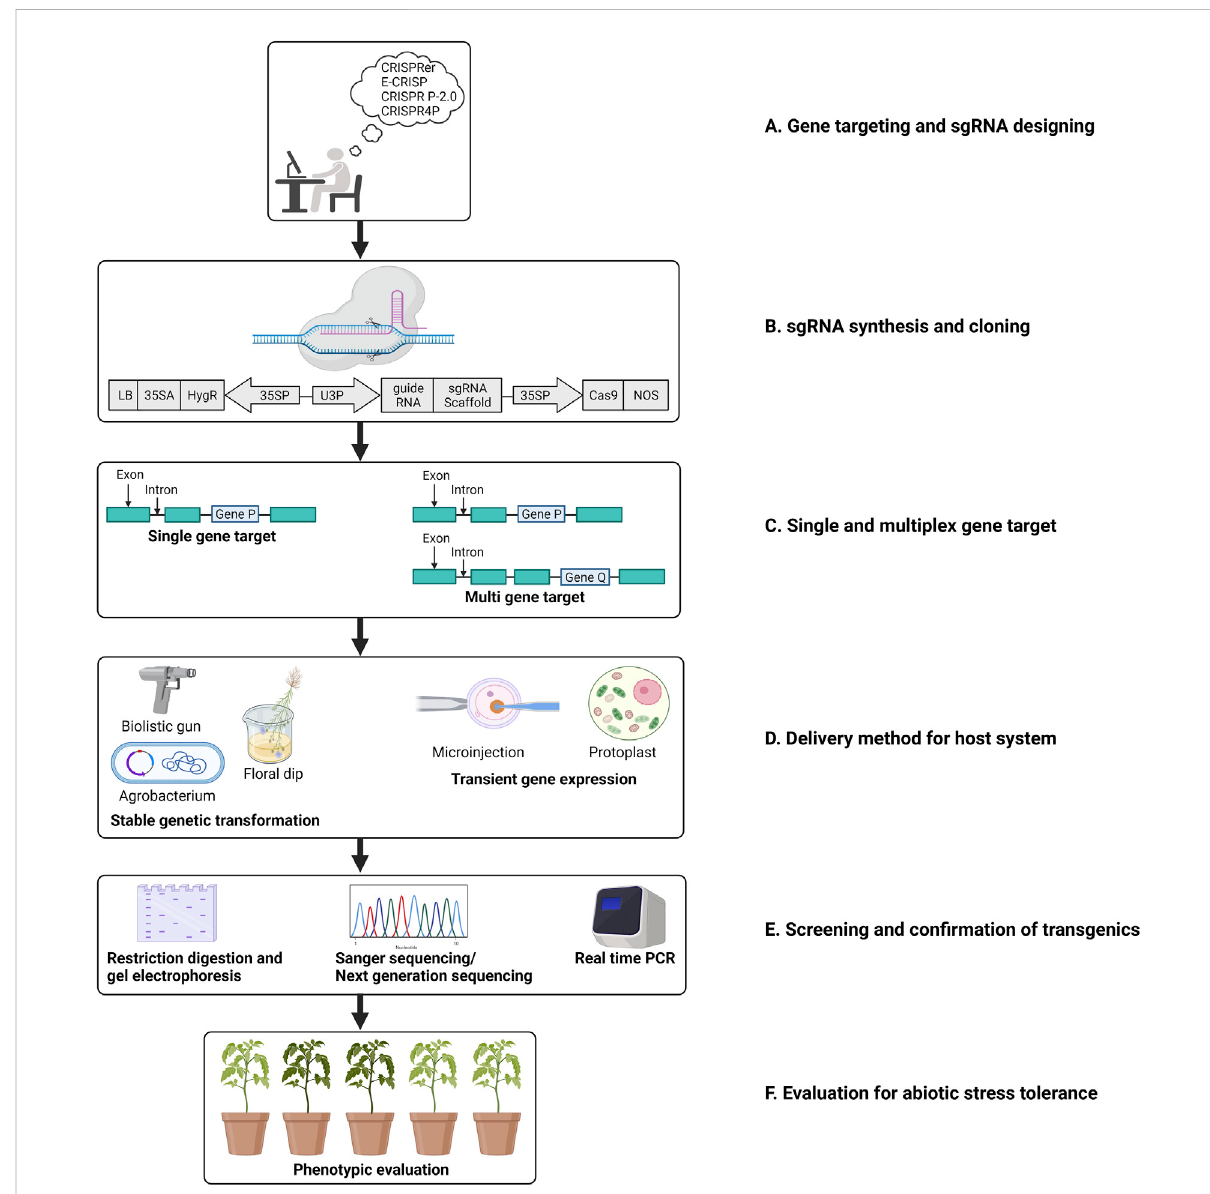
FIGURE 1 SchematicrepresentationofstepsinvolvedinaCRISPR/Casmediatedgeneeditinginplants. (A) .TargetgeneselectionanddesigningofsgRNA; (B) .EngineeringthesgRNAinanappropriatebinaryvector. (C) .CRISPR/Casmediatedcleavageviasingle/multiplexgeneediting. (D) .Transformation in plants; (E) . Screening and evaluation of the crops edited; (F) . Evaluation of the plants for selecting transgene-free plant with edited gene(s) regulating the trait of interest (adapted from Jaggannath et al.